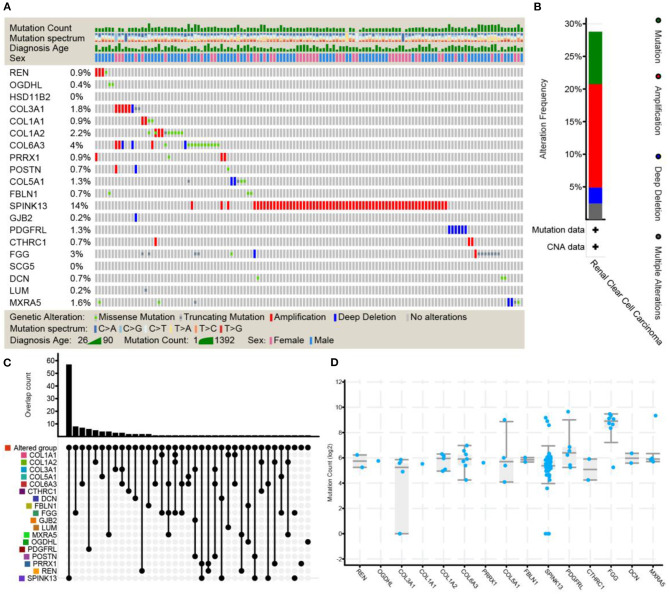
The frequency of genetic alterations (including mutations, amplifications, deletions, and fusions associated with clinical parameters) of shared DEGs was evaluated through ccRCC studies using cBioPortal. Stacked plots show mutational burden (histogram, top), mutations in shared DEGs (tile plot, middle), and mutational marks (bottom) (A). Overall description and cancer type summary of the selected sample (B). The histogram combined with the dotted-line graph shows the overlap of samples (patients) (C). Box plots display shared DEG mutation counts based on the Kruskal–Wallis test (p = 0.0140) (D). HSD11B2, POSTN, GJB2, SCG5, and LUM completely overlapped with other selected groups and were excluded from the analyses in other tabs.